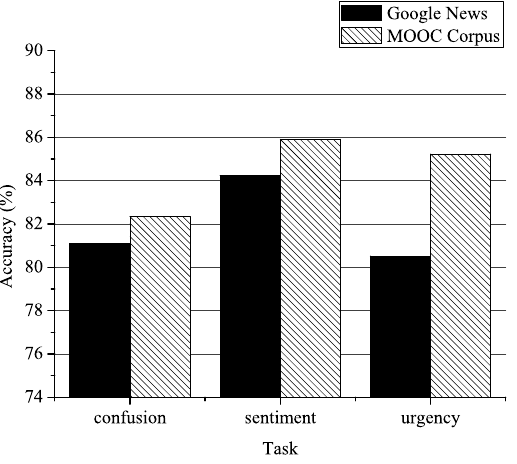
Figure 2. Comparison of word embeddings pre-trained on Google News or on the MOOC